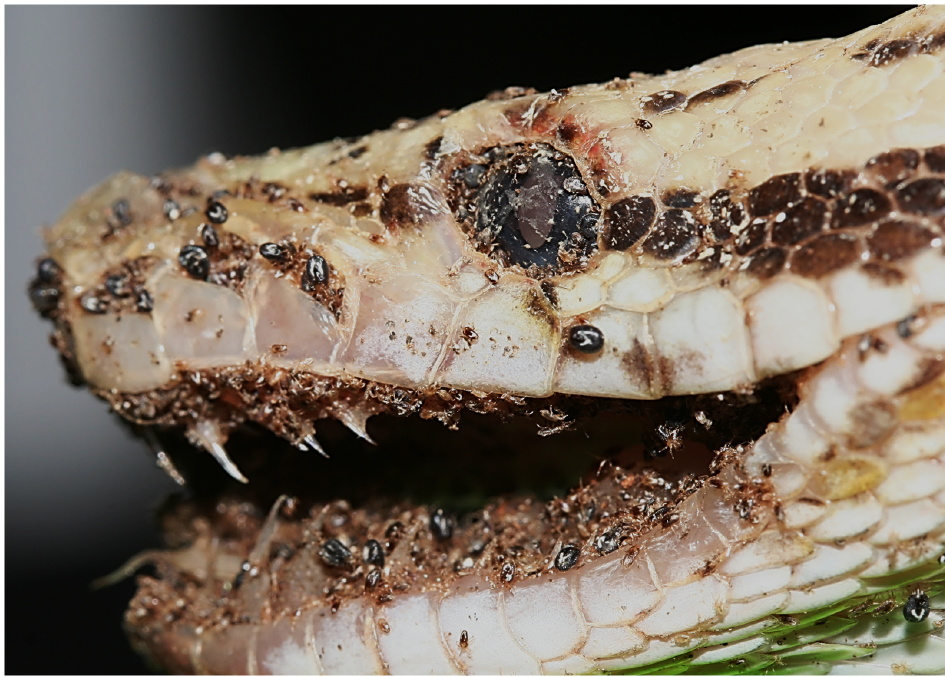
Figure 12. Extreme infestation with snake mites ( Ophionyssus natricis ) in a deceased ball python ( Python regius ).